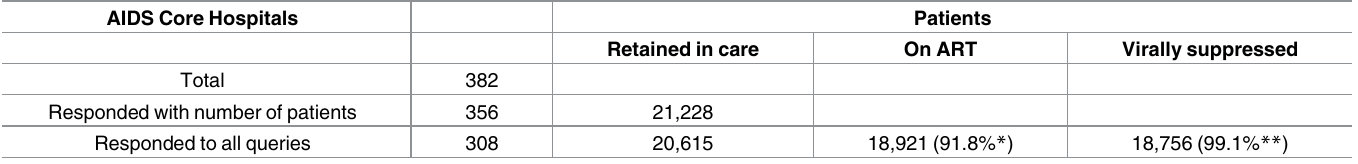
Table 2. Results of the questionnaire survey in AIDS Core Hospitals.